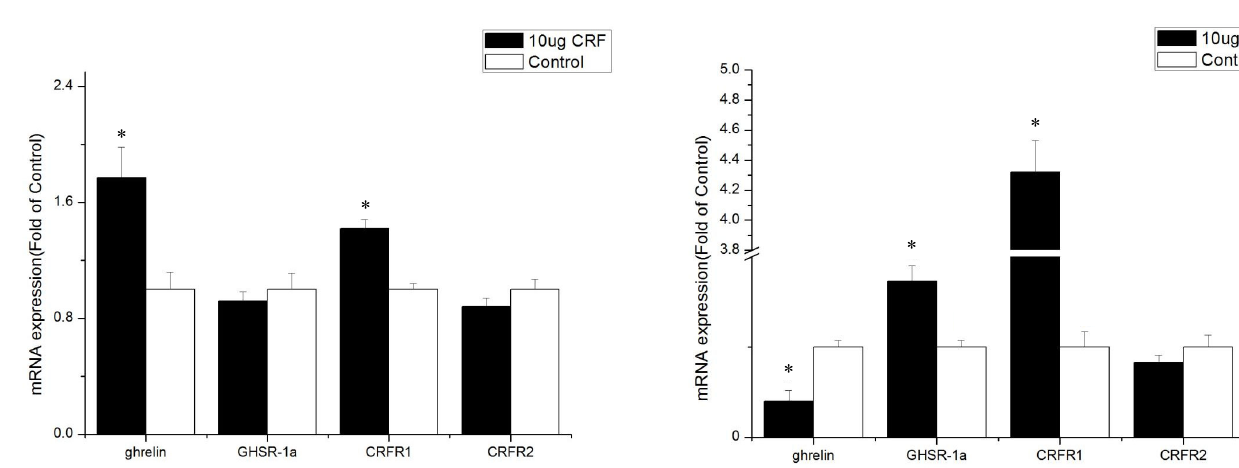
Figure 4. Effect of intracerebroventricular injection of corticotropin-releasing factor (CRF) on genes in the jejunum of broiler chickens. Control = control group (basal diet); 10 μg = 10 μg/kg body weight. n = 8. * p<0.05 (compared with control).